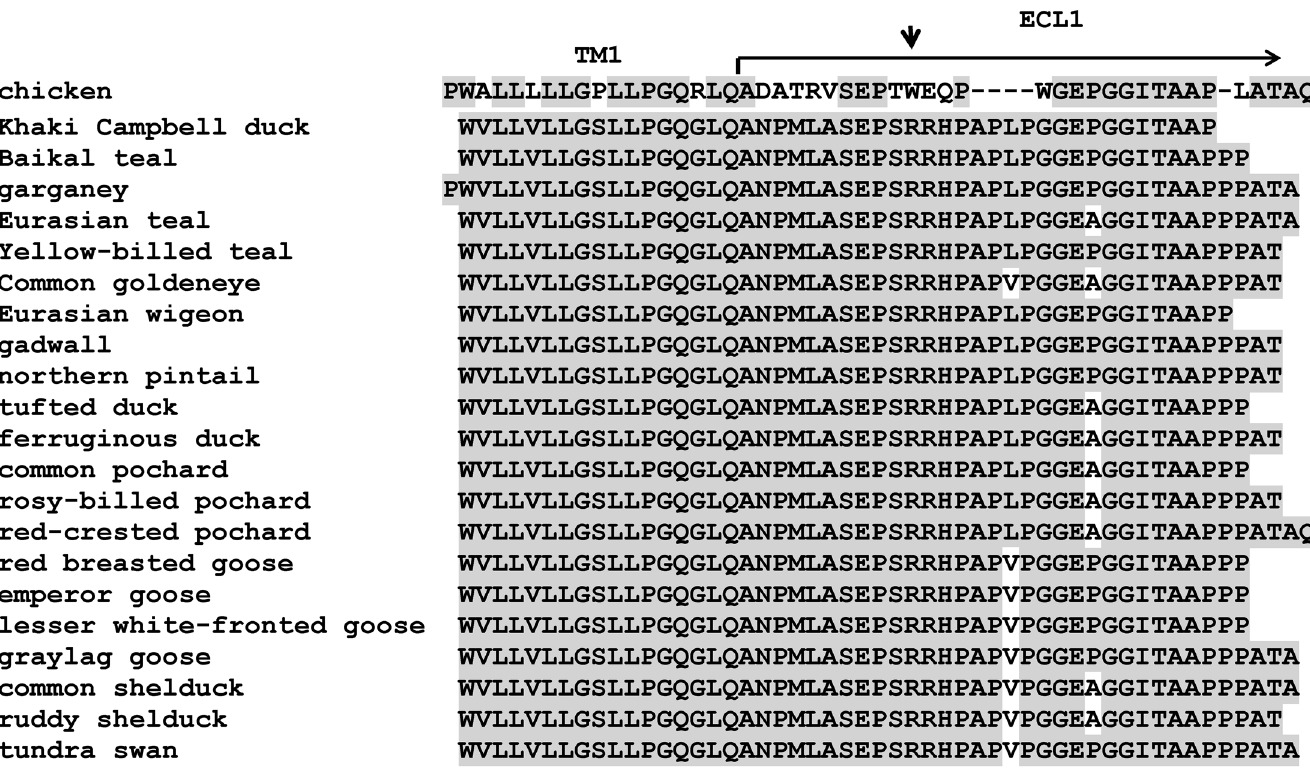
Fig 2. Alignment of the left part of ECL1 and adjacent TM1 of NHE1 in the duck and goose species. The deduced amino-acid sequences of ECL1 and corresponding chNHE1 amino-acids 11 to 58 are compared and aligned. The border between ECL1 and putative transmembrane domain TM1 is depicted by horizontal arrow. The W38 amino-acid residue in chNHE1 is shown as a vertical arrow. Amino acids matching the consensus sequence of anseriforms are on a gray background.